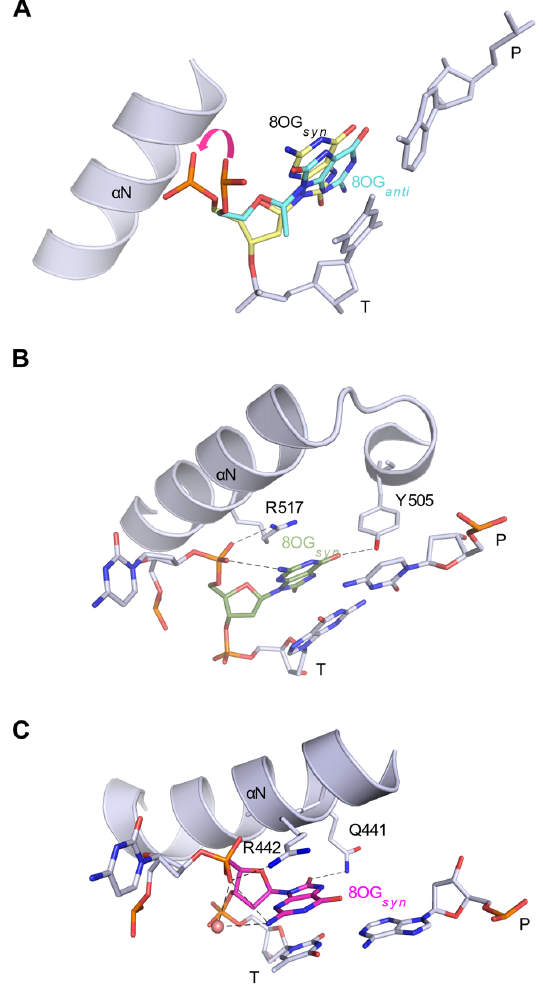
Figure 2. Structures of 1nt-gapped DNA substrates containing 8OG in the templating position. Stick representation of the DNA (unpaired 8OG, downstream template nucleotide and primer terminal base pair) bound to Pols β ( A ), λ ( B ) and µ ( C ) binary complexes. In A, the two conformations of 8OG, syn and anti , in the Pol β complex (PDB ID code 3RJE [54]), are shown in yellow and cyan, respectively. The magenta arrow indicates the rotation of the 5′-phosphate necessary to accommodate the O8 atom of the 8OG. A single conformation of the template 8OG is observed for Pols λ (PDB ID code 5IIO [34]) and µ (PDB ID code 6P1M [35]). α-helix N in the thumb subdomain is shown (gray ribbon). Side chains interacting with the template 8OG are drawn in stick representation, with putative hydrogen bonds indicated by dashed lines. P and T indicate the primer and template strands, respectively.